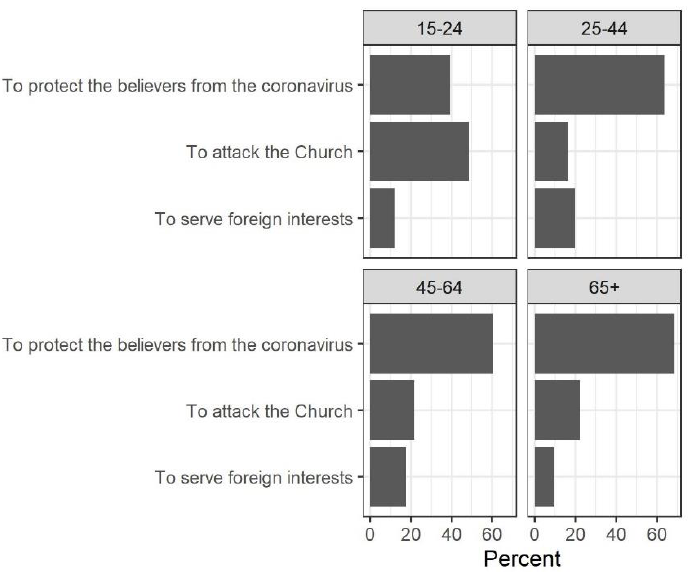
Figure A2. Cross-tabulation of attitudes of believers for closing of Churches by age (% by age). Χ 2 = 17.1786, df = 6, p = 0.009.